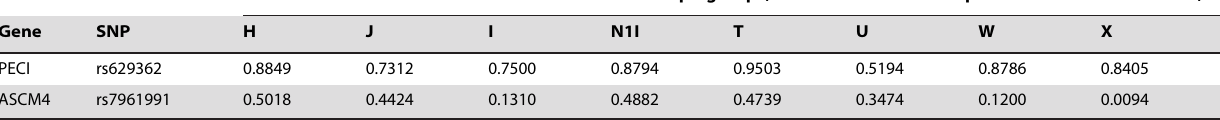
Table 2. Mitochondrial DNA haplogroup associations with highly significant SNPs in the PECI and ASCM4 genes.